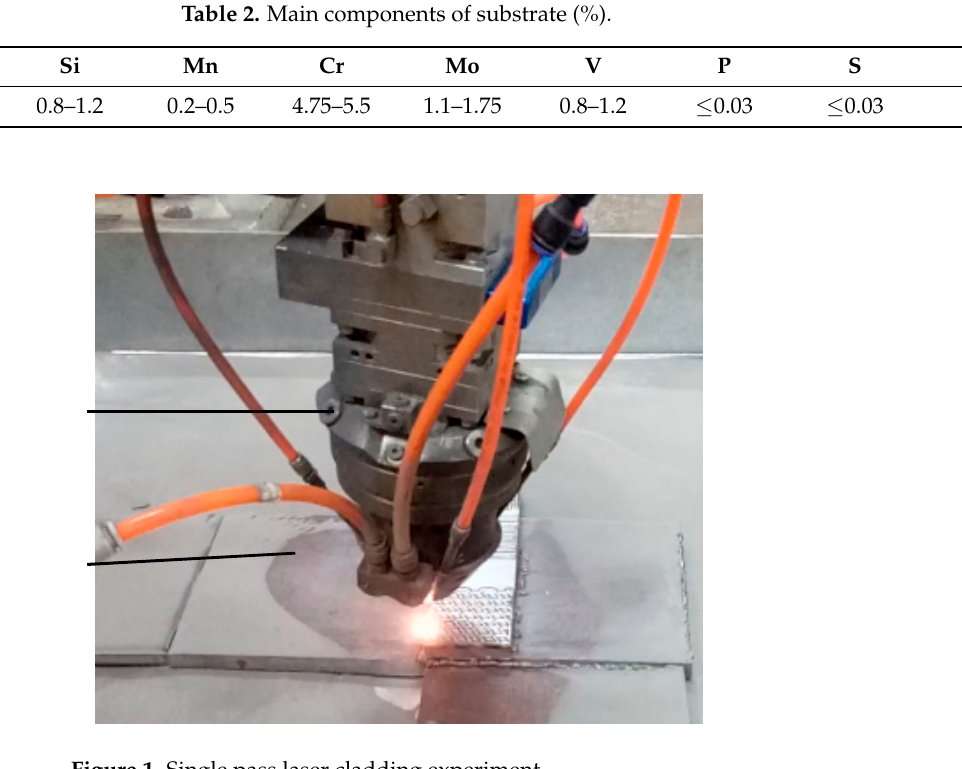
Table 3. Orthogonal experimental design of process